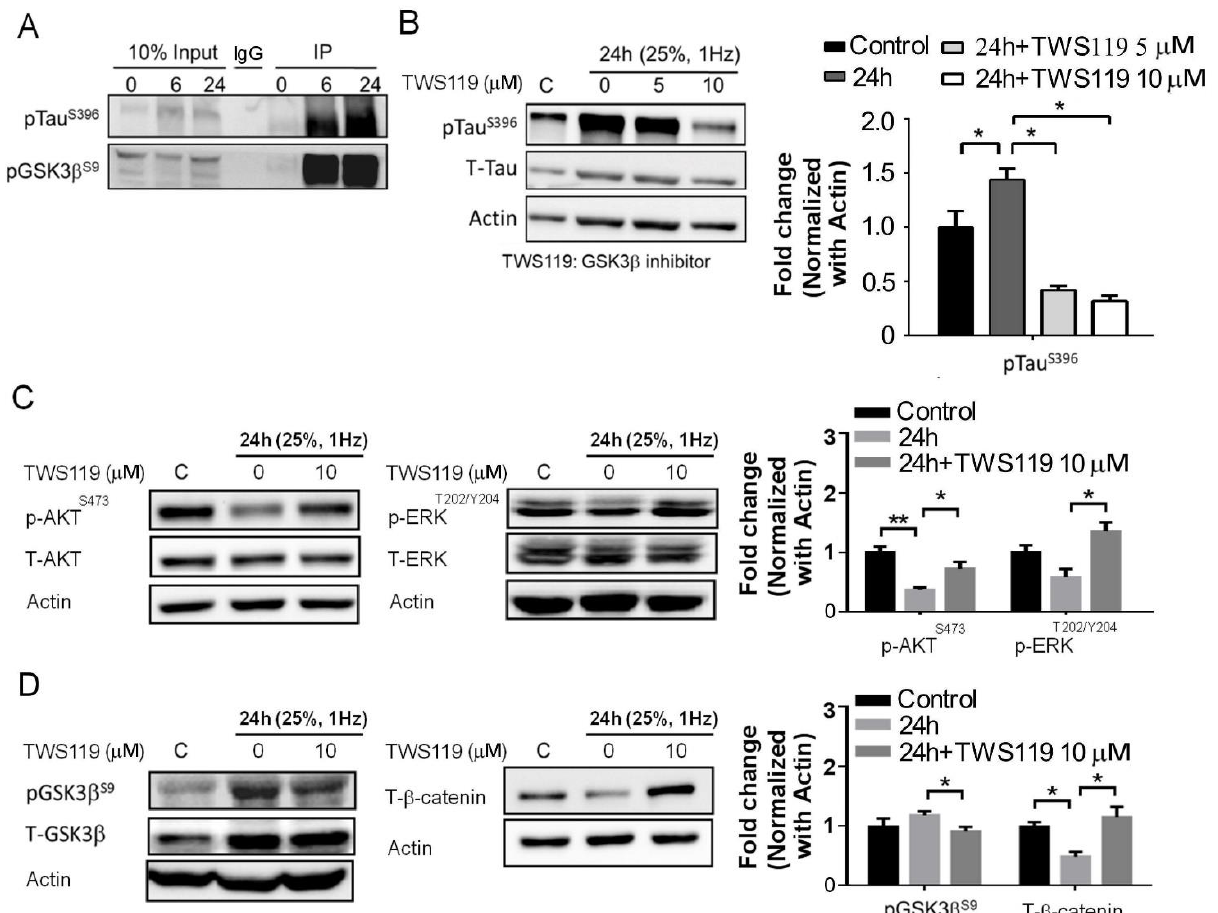
Figure 4. Mechanical injury promotes p-Tau-pGSK3 β complex formation and affects the insulin pathway. ( A ) Co-immunoprecipitation was performed to study the p-Tau S396 and anti-GSK-3 β S9 protein complex formation. The input protein comprises 10% of the total lysates, and the remaining 90% protein lysate was incubated with the p-Tau S396 or anti-GSK-3 β S9 primary antibody. Co-immunoprecipitation was performed to study the p-Tau and p-GSK3 β protein complex formation. The input protein comprises 10% of the total lysates, and the remaining 90% protein lysate was incubated with the p-GSK3 β primary antibody. ( B ) We analyzed the function of p-GSK3 β by adding the p-GSK3 β inhibitor and TWS119 while the cells were being stretched. p-Tau s396 protein levels significantly decreased in the 25%, 1 Hz-TWS119 group. ( C , D ) We conducted Western blot to analyze phosphorylated p-Akt S473 , p-ERK T202/Y204 , p-GSK-3 β S9 , and T- β -catenin protein in SH-SY5Y cells, before and after the stretching or TWS119 administration. The immunoblot demonstrates greater levels of p-Akt S473 , p-ERK T202/Y204 , p-GSK-3 β S9 , and T- β -cateninin SH-SY5Y cells, before and after the stretching or TWS119 administration. ** p < 0.01; * p < 0.05. GSK3 β , glycogen synthase kinase 3; ERK, extracellular-signal-regulated